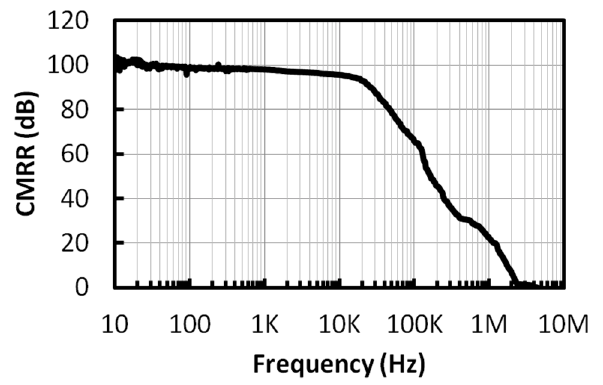
Figure 14. The measured CMRR of the chopper IA.